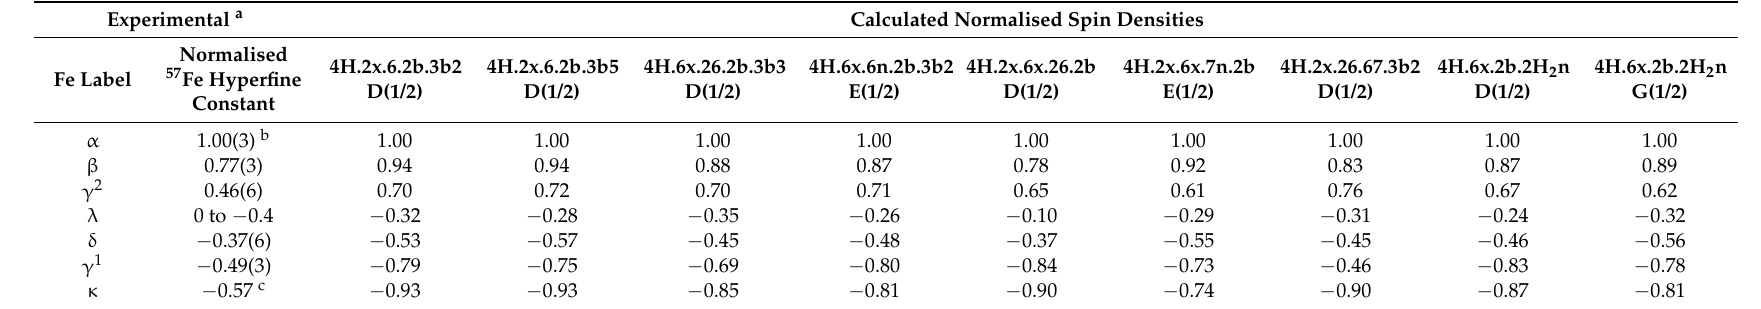
Table 2. Sorted and normalised hyperfine constants compared with calculated normalised spin